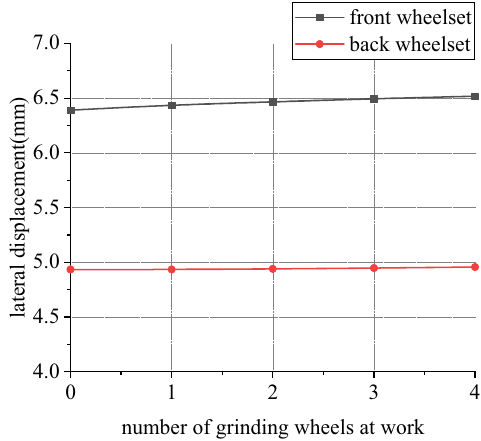
Figure 31. Grinding wheels and lateral displacement (case 4).